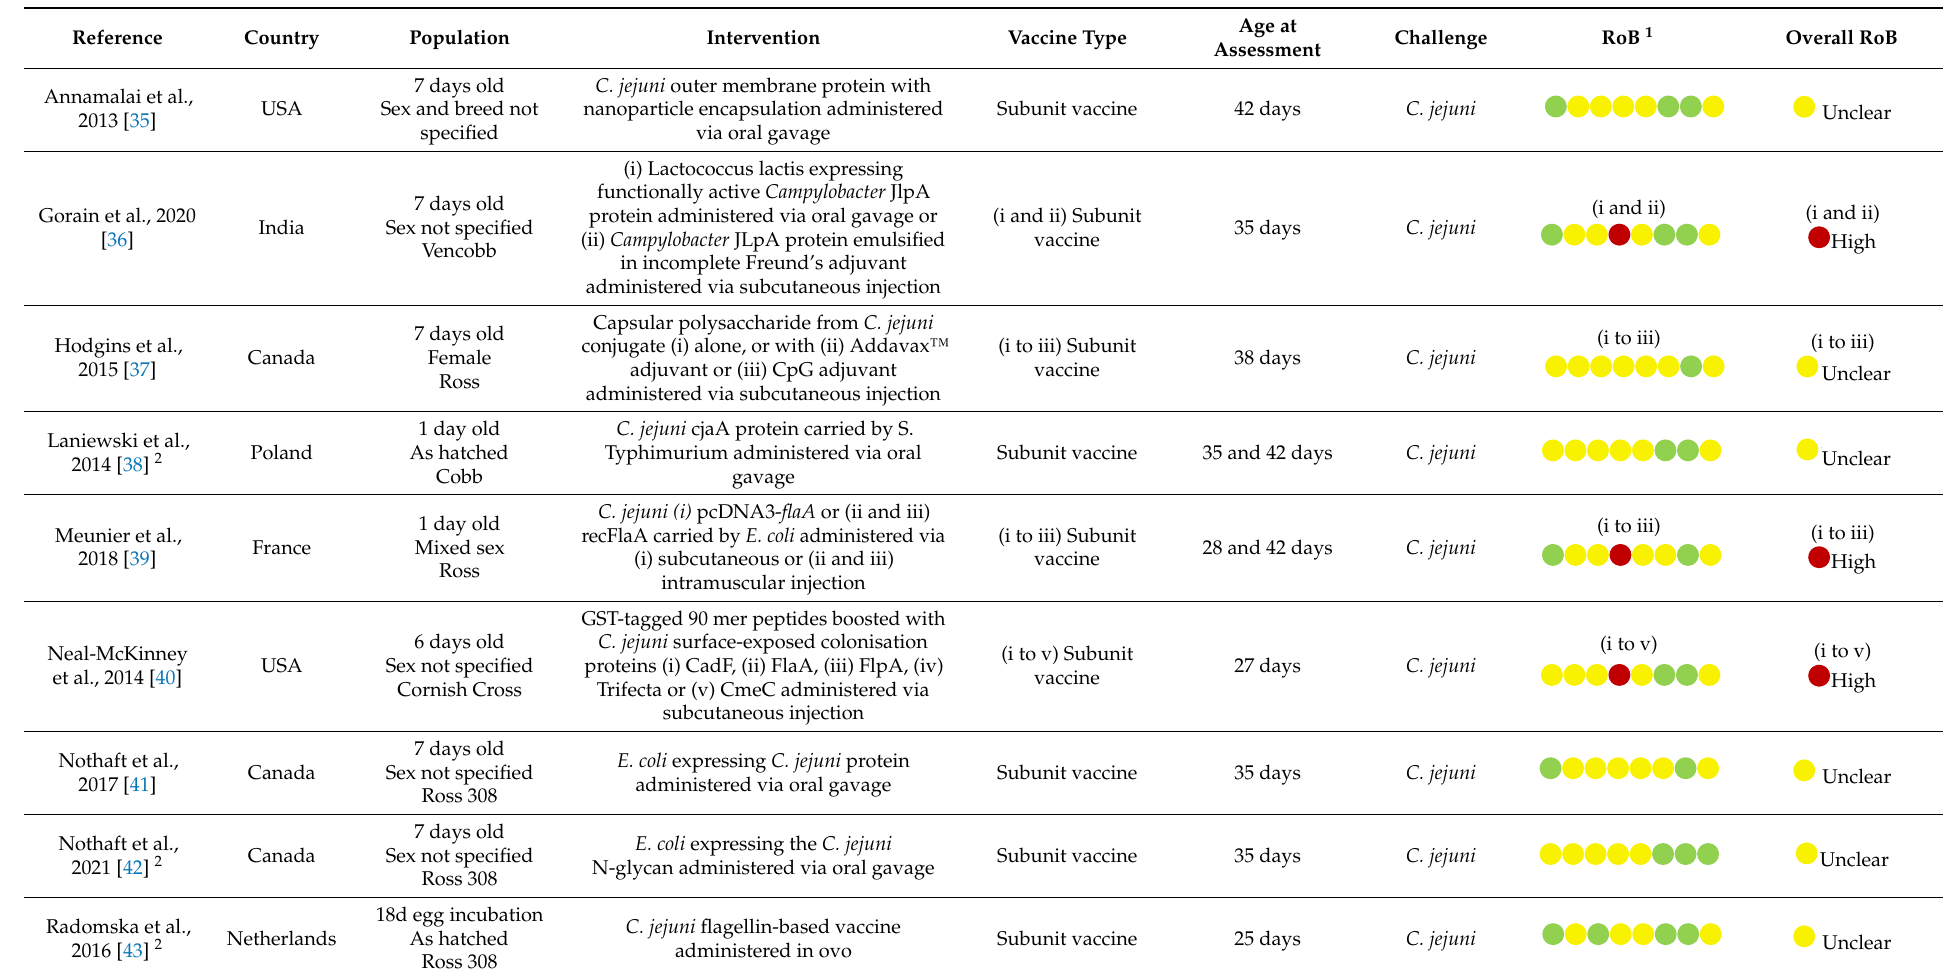
Table 2. Summary of key characteristics of studies that investigated the effects of Campylobacter vaccines on caecal Campylobacter .